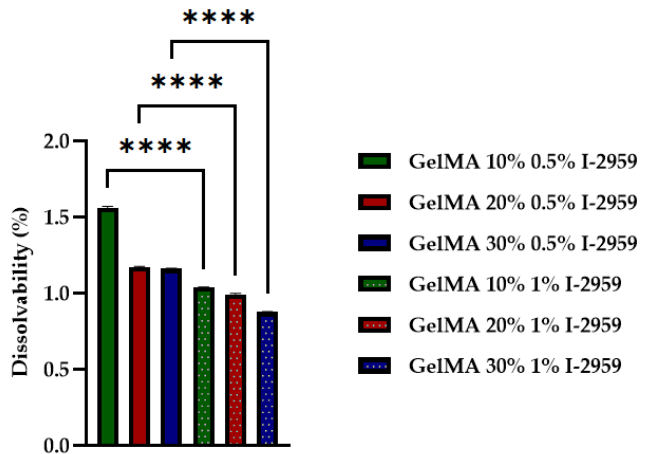
Figure 8. Swelling ratio of GelMA-based hydrogel with different concentrations of GelMA and I-2959. Statistical significance: **** p < 0.0001.